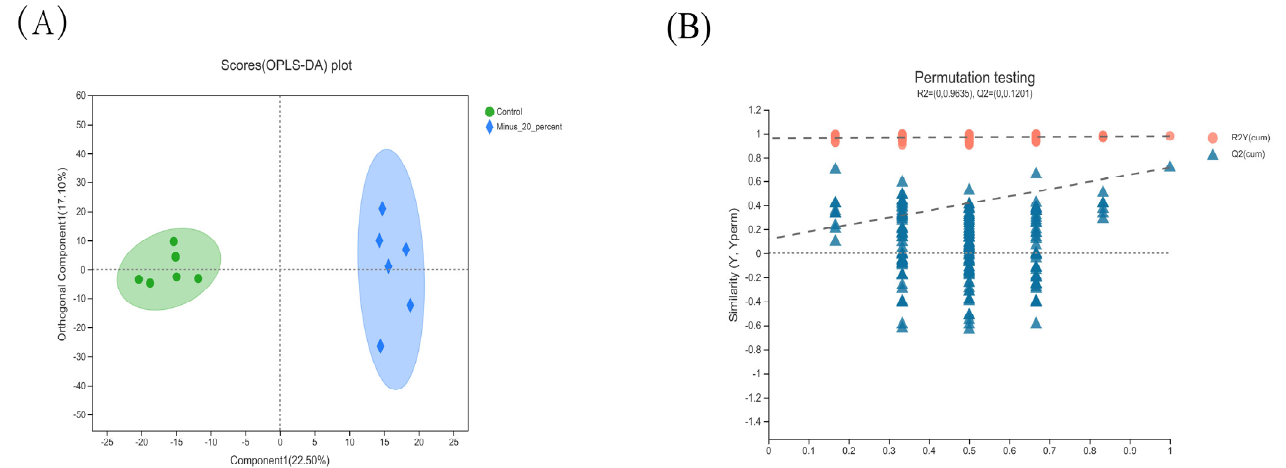
Figure 1. OPLS-DA score plot and OPLS-DA model validation diagram for metabolomics data in longissimus thoracis muscle of Shaziling pigs ( n = 6). ( A ) OPLS-DA score plot of LTM metabolites (control vs. − 20%). ( B ) OPLS-DA model validation diagram.